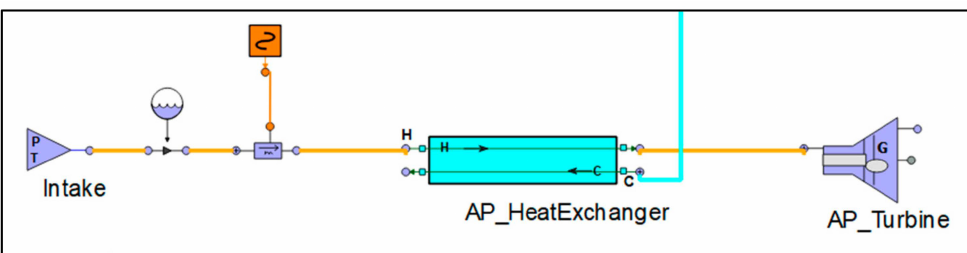
Figure 15. Front module, detail of ECS